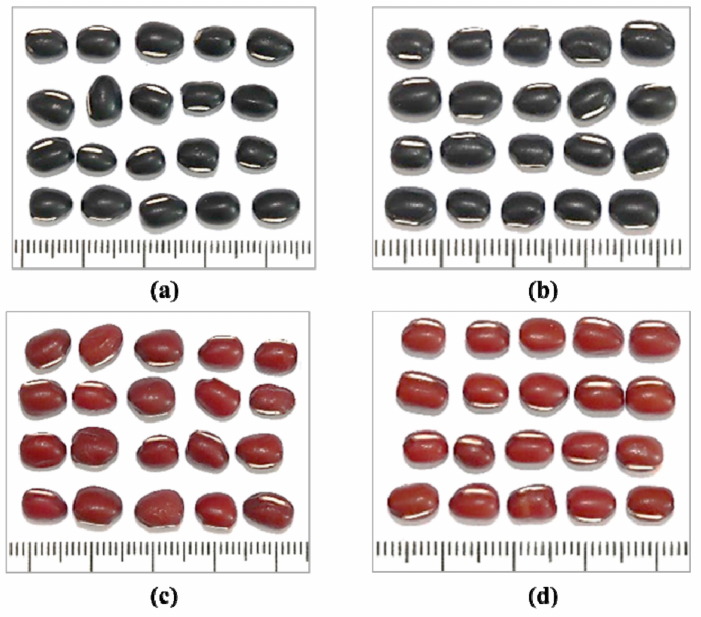
Figure 1. Seed samples of four Korean adzuki bean cultivars. ( a ): Chilbopat; ( b ): Geomguseul; ( c ): Arari; ( d ):